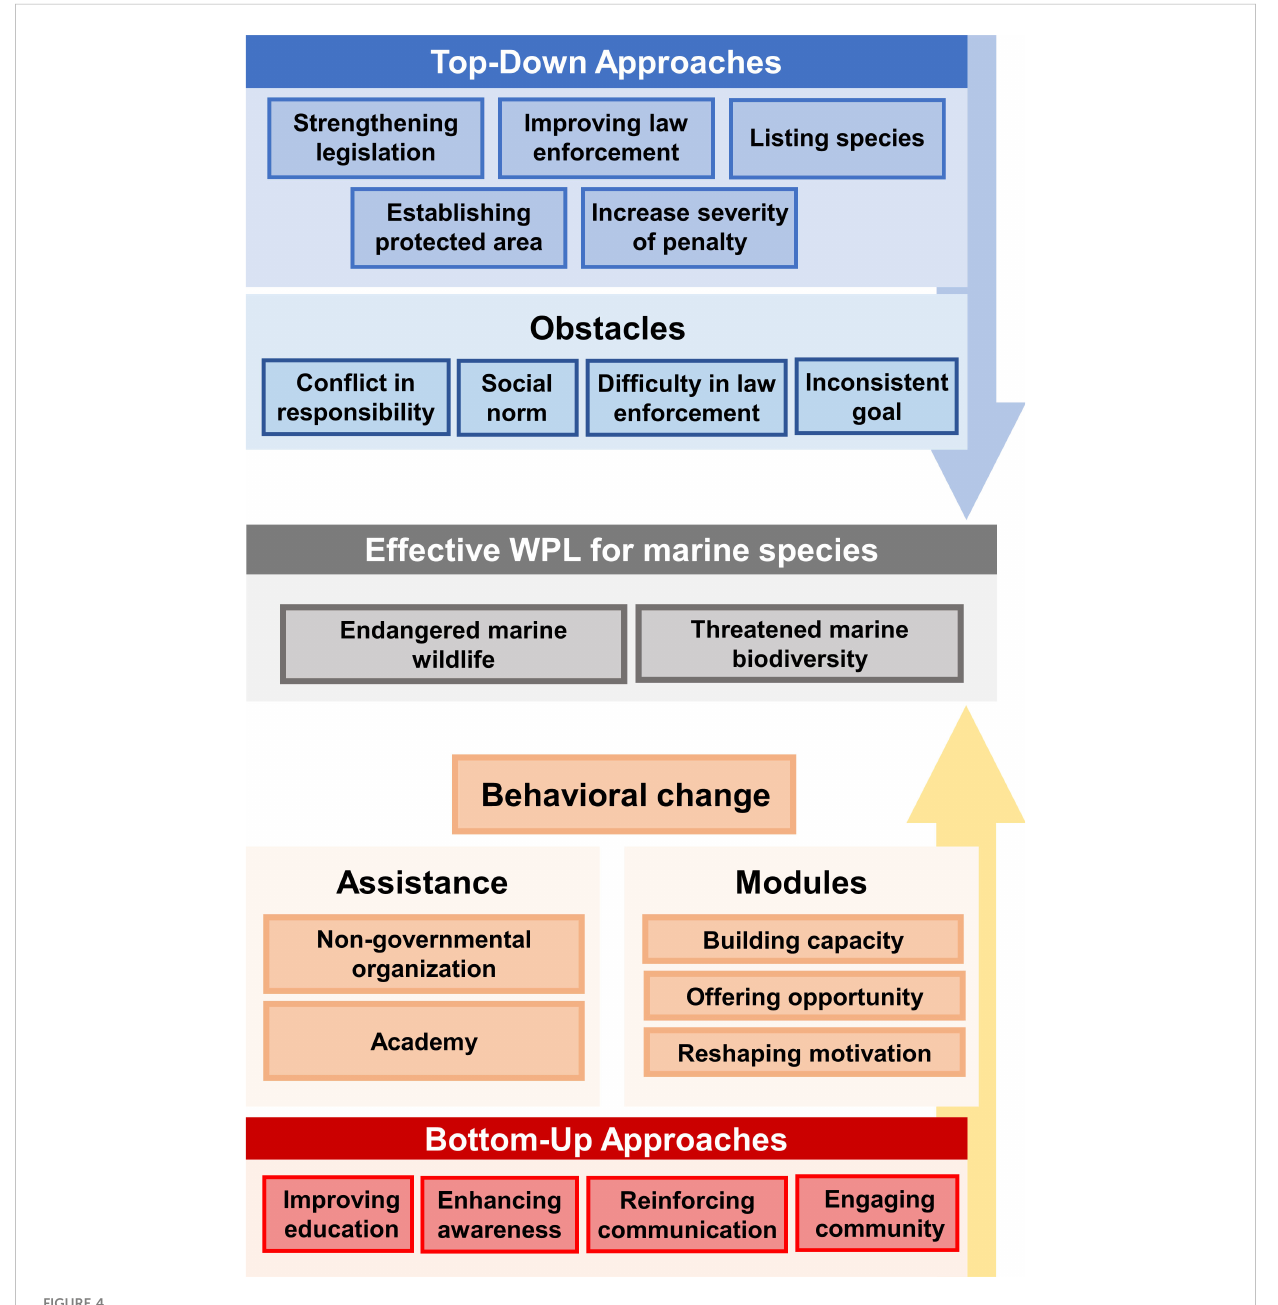
FIGURE 4 Conceptual framework for achieving an effective Wildlife Protection Law for marine species in